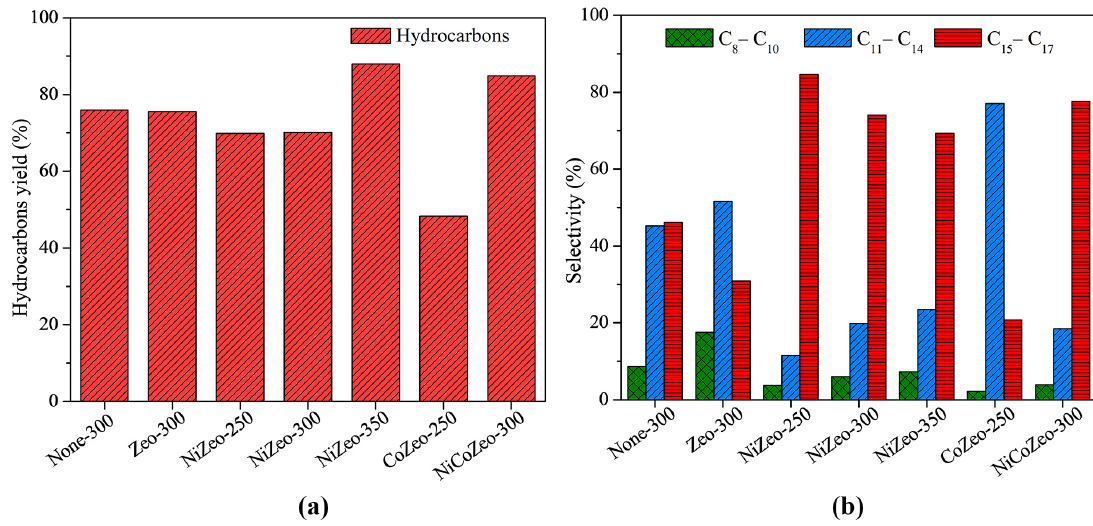
Figure 9 Figure 9. Catalytic activity and selectivity in DO reactions of PFAD. ( a ) hydrocarbons yield and ( b )